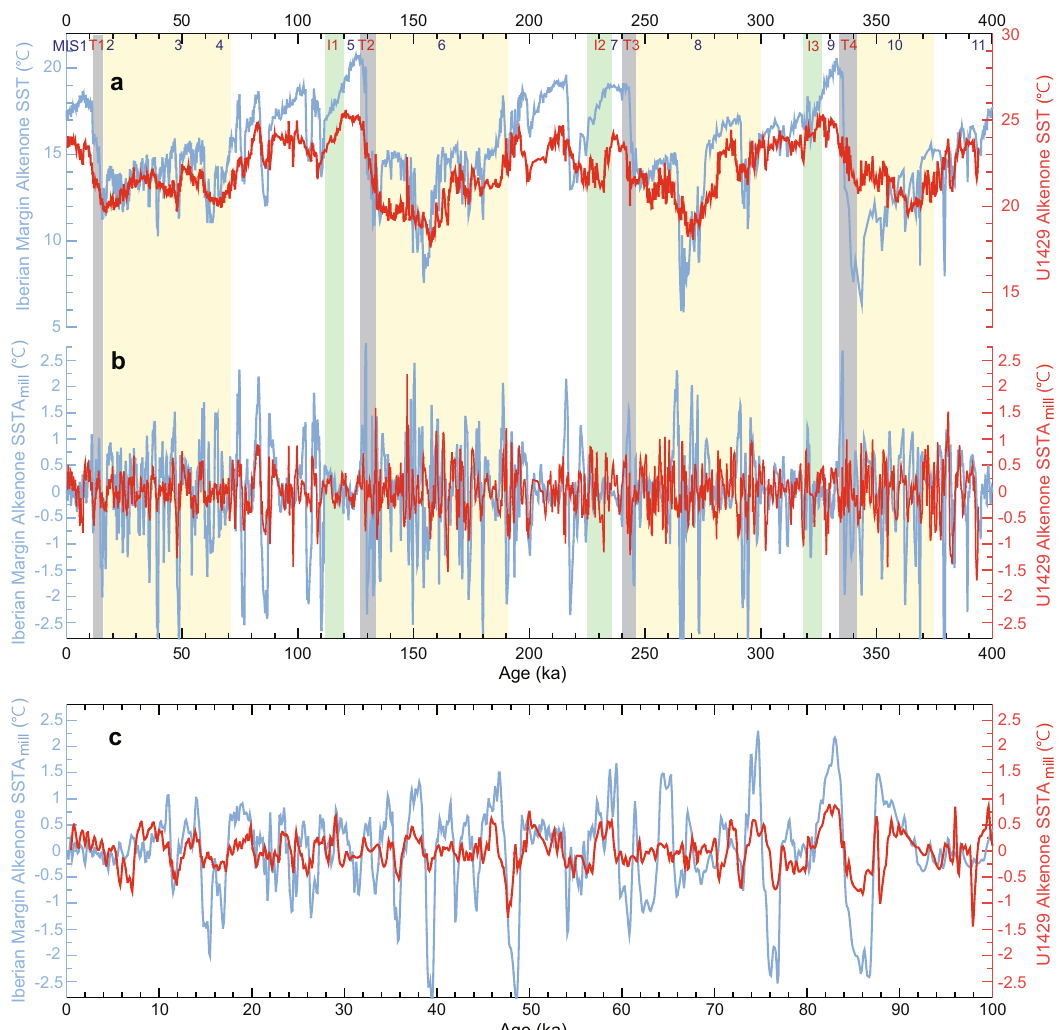
Fig. 9 Comparison of alkenone-based sea surface temperature (SST) between the North Atlantic and North Paci fi c. a Comparison of orbital-scale and b millennial-scale variations in alkenone-based SST records from Site U1429 (red), and Iberian margin Cores MD01-2443 and MD01-2444 (blue) 42, 43 over the past 400 kyr. Millennial-scale variability was extracted from all datasets by applying a bandpass fi lter with cuts of periods of 300 years and 10,000 years. Yellow, grey, and green shaded areas indicate the glacial period, termination, and inception periods, respectively. c Same as ( b ) but zoomed into the records over the last 100